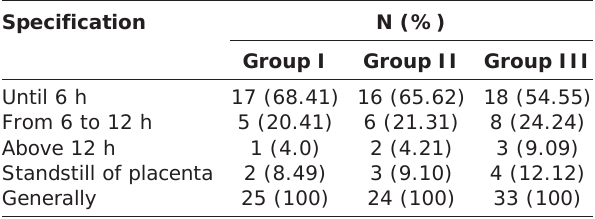
Table-3: Time of placenta isolation (in hours) after birth in cows in examined